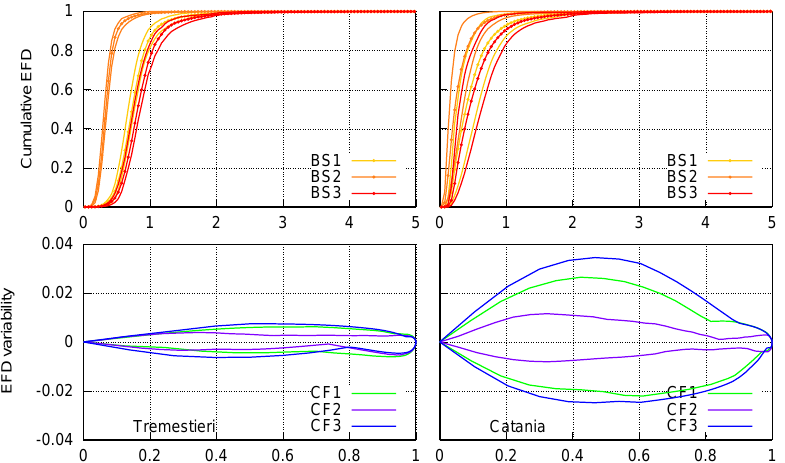
Fig. 9. Distribution of functions BS1, BS2 and BS3 for Catania and Tremestieri together with the minimum and maximum envelopes of monthly EFDs (upper panels). The distance between the lower and upper envelopes of the corresponding control functions are given in the lower